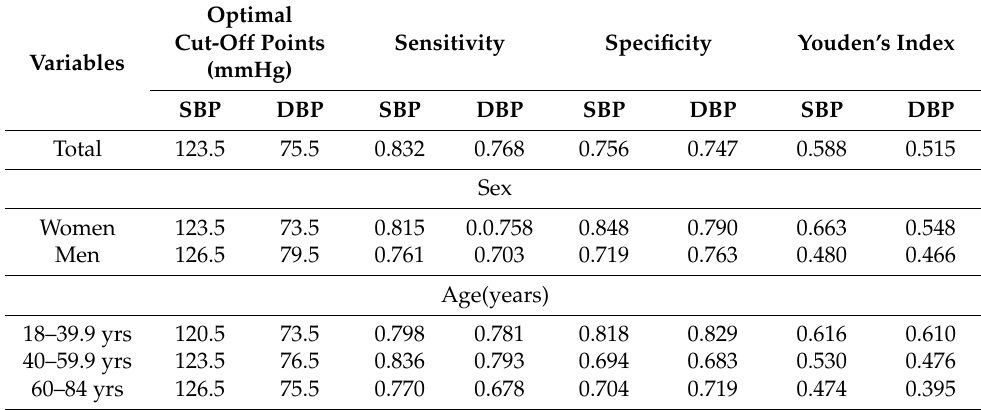
Table 4. Optimal cut-off points, sensitivity, and specificity for blood pressure to identify